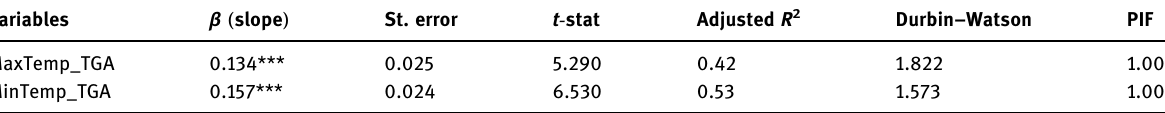
Figure 5: Trend of temperature in te ff growing areas, 1981 – 2018. Source: Computed based on raw data from NMA of Ethiopia, 2019. Table 3: Temperature trend ( slope ) test - statistic for te ff growing areas over 1981 – 2018 Variables